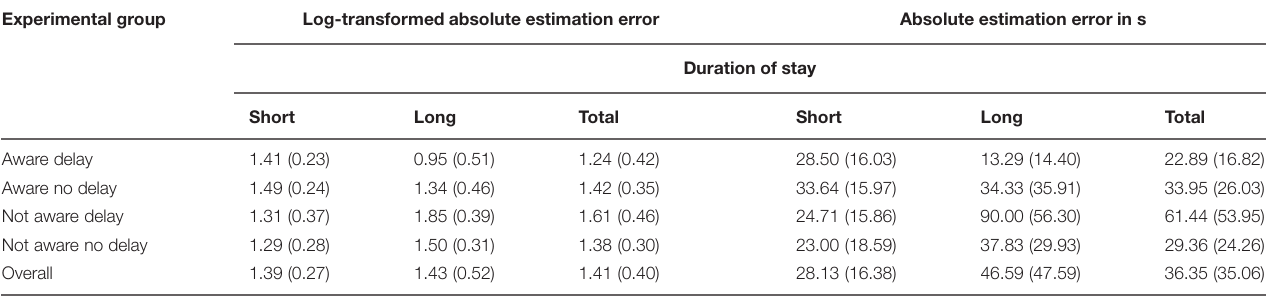
TABLE 1 | Mean and standard deviation of absolute time estimation errors (log-transformed and non-transformed) for experimental and control groups.